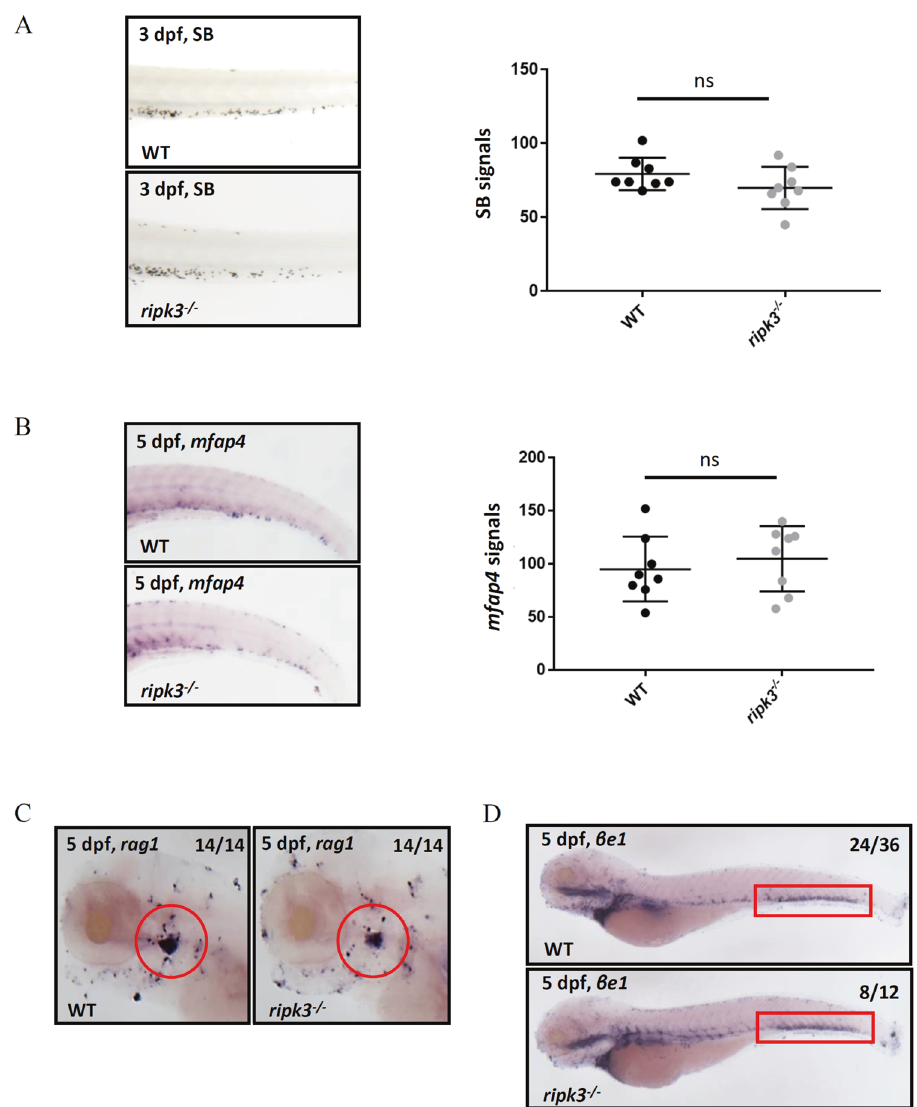
Fig. 2 Hematopoiesis was unaltered in ripk3 -de fi cient larvae. A SB staining showing unchanged neutrophils ( n = 8, Student ’ s t -test). B WISH of mfap4 showing unchanged macrophages ( n = 8, Student ’ s t -test). C WISH of rag1 showing normal T lymphocytes (red circle showing the thymus) (Fisher ’ s exact tests, n = 14). D WISH of β e1 showing normal erythrocytes (red box showing the caudal hematopoietic tissue) (Fisher ’ s exact tests, n >